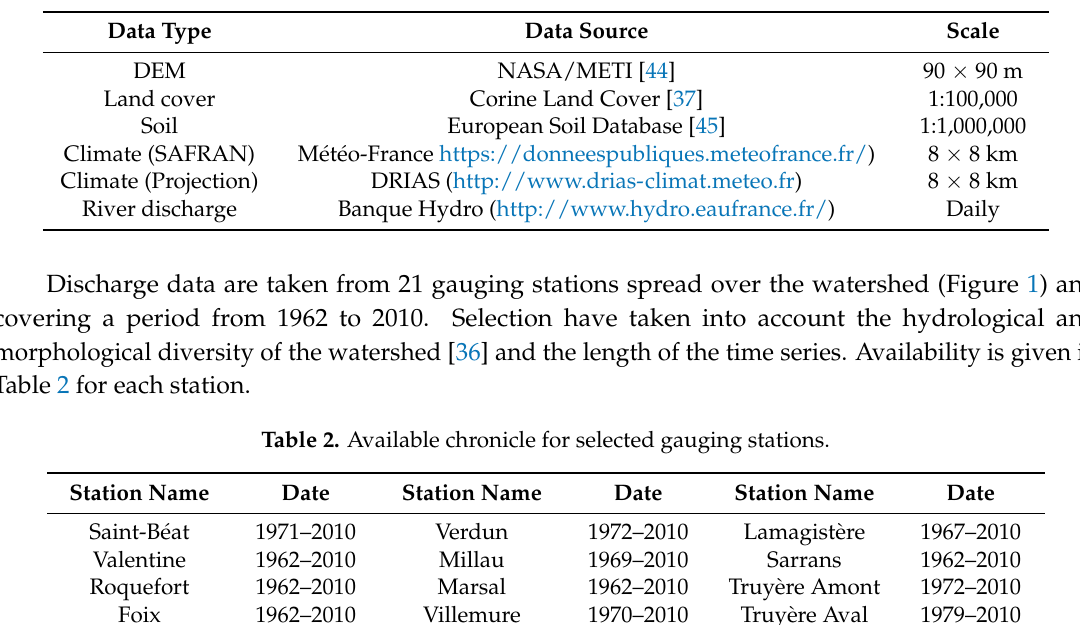
Table 1. Data sources.